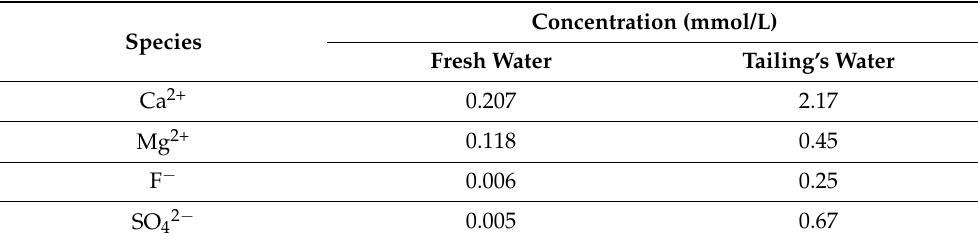
Table 1. Composition of two available water sources at a mine site